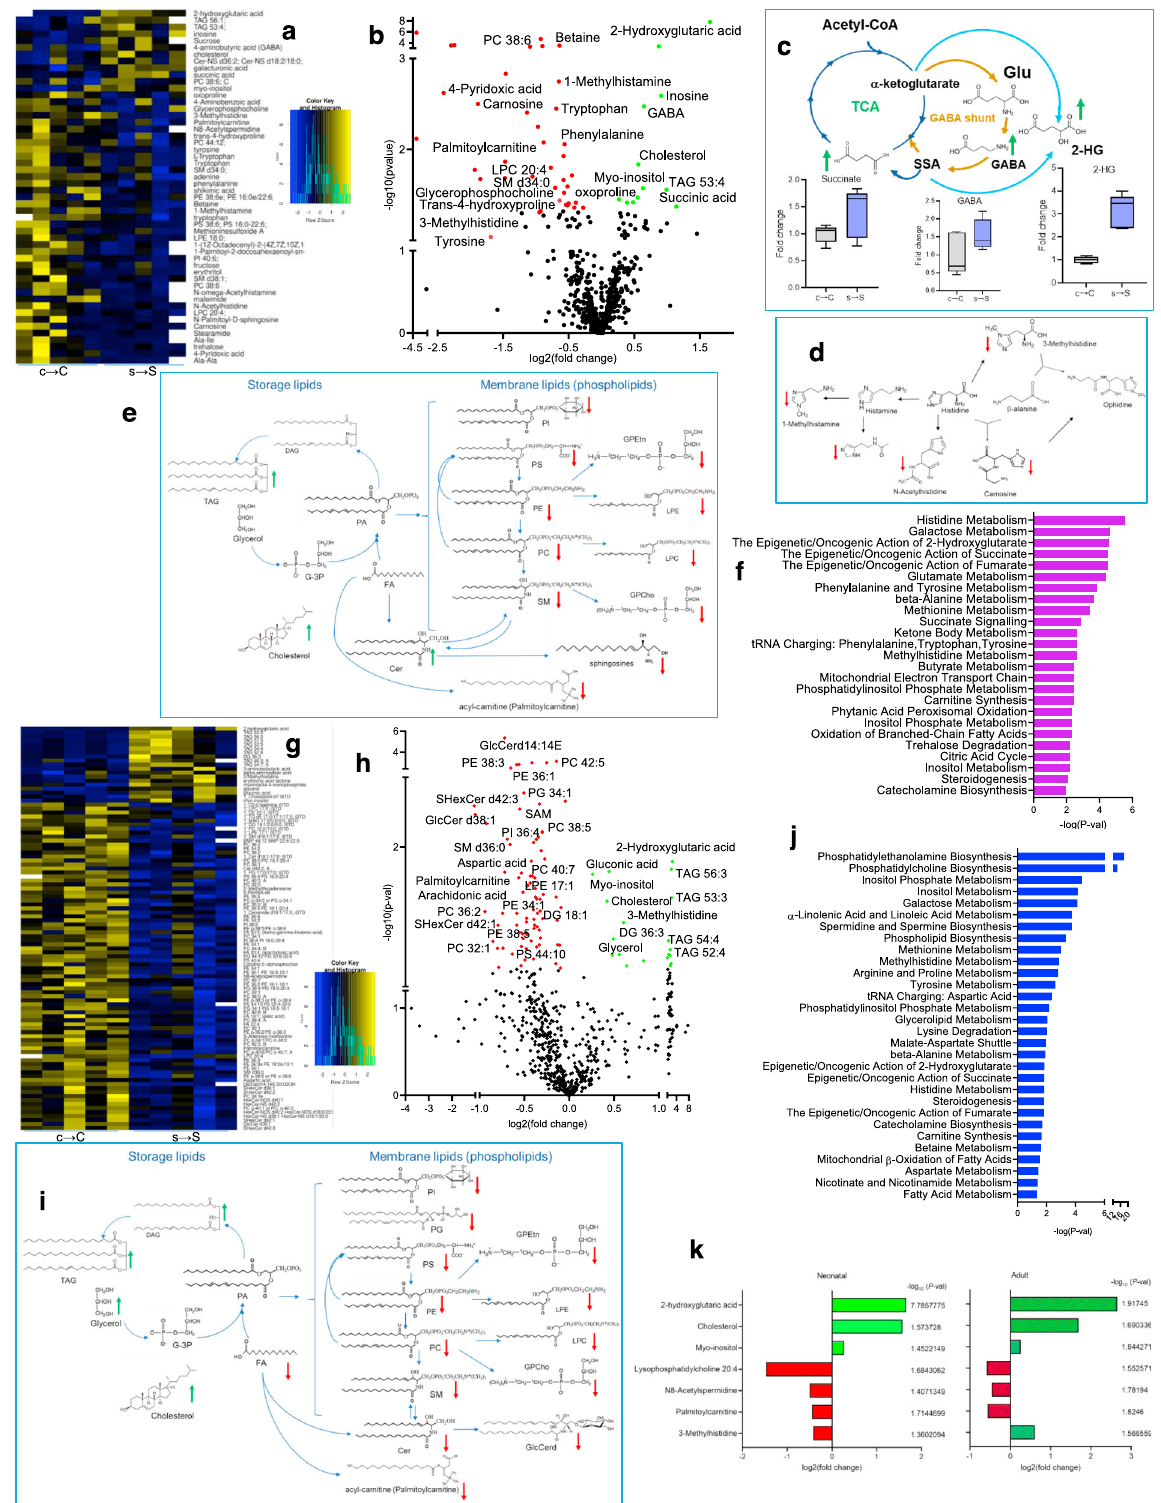
Bioinformatic analysis of metabolites altered in the brains of neonatal s → S pups substantiated enrichment of pathways associated with epigenetic processes, energy metabolism, mitochon- drial functions, fatty acid oxidation, and complex lipid metabolism (FDR < 0.05, Fig. 2f, Supplementary Data 2). In the adult brains, 2-HG again exhibited the highest change (>6-fold increase) in the brains of the s → S pups,